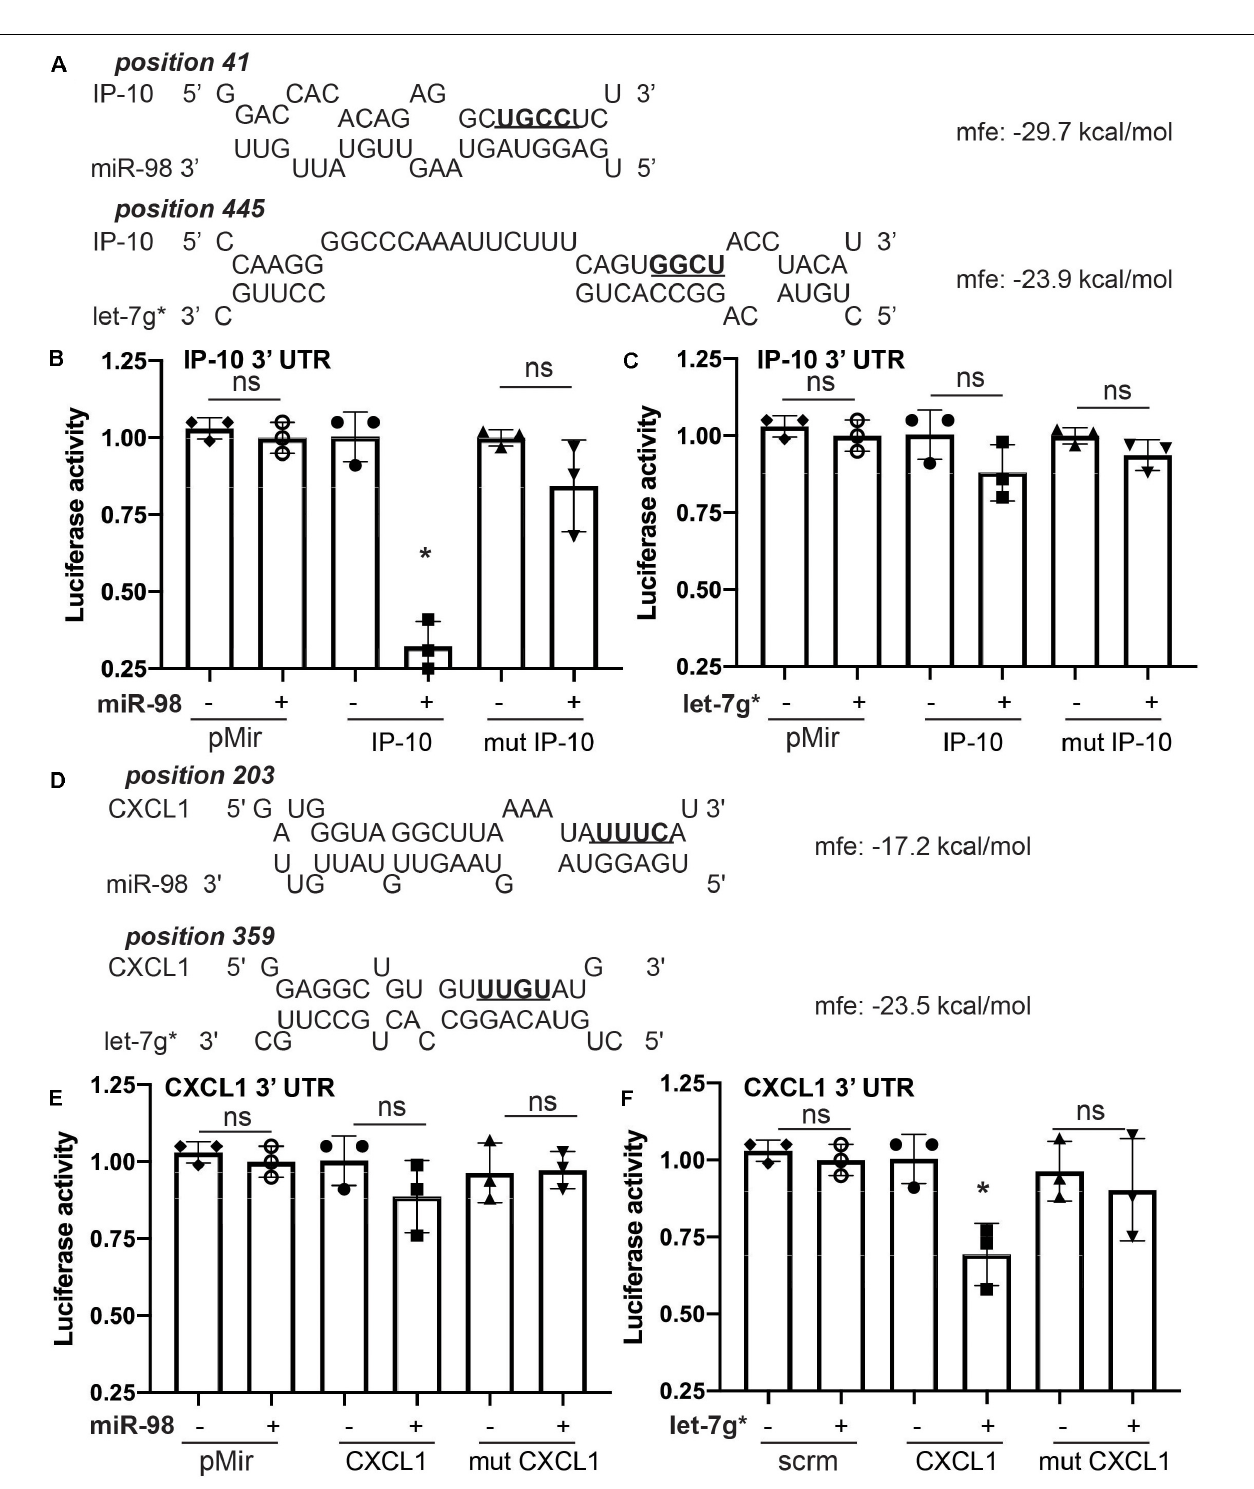
FIGURE 2 | Let-7g* and miR-98 selectively target different cytokine mRNAs. Prediction analysis for miR-98 and let-7g* for the ability to create miR-mRNA hybrid with IP-10 (A) and CXCL1 (D) 3 (cid:48) UTRs, with minimum free energy recorded. Luciferase activity for IP-10 (cid:48) s 3 (cid:48) UTR reporter in HEK-293 cells transfected with mimic oligos of miR-98 (B) or let-7g* (C) . Luciferase activity for CXCL1’s 3 (cid:48) UTR reporter with mimic oligos of miR-98 (E) or let-7g* (F) . 3 (cid:48) UTR sequences of IP-10 and CXCL1 were mutated in the seed-binding site (underlined and bolded). Data are shown as mean ± SD. * p < 0.05.